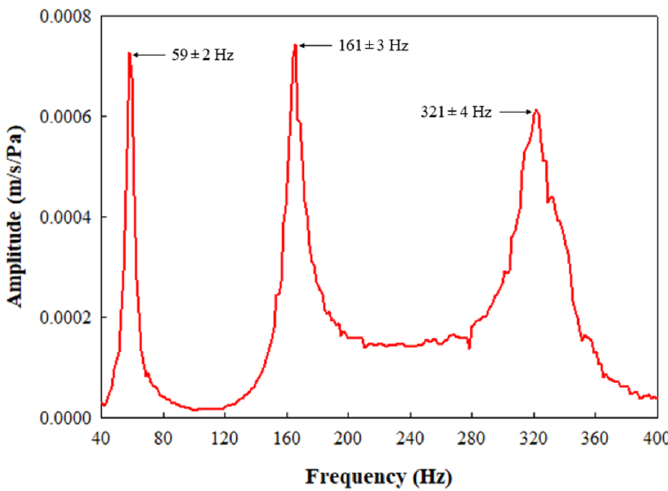
Figure 6. Frequency response function (FRF) of five cantilever beams with three eigenfrequencies (59 Hz, 161 Hz, and 321 Hz).